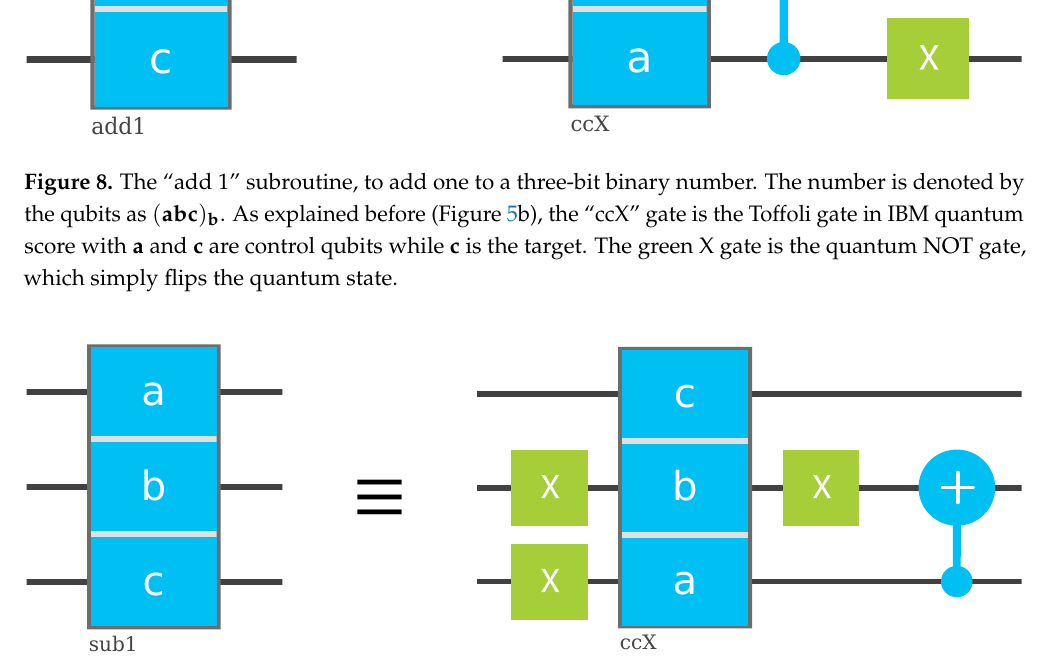
Figure 9. The “sub 1” subroutine, to subtract one from a three-bit binary number. The number is denoted by the qubits as ( abc ) b . The “”ccX” gate is the Toffoli gate (Figure 5b). Where the qubits denoted by “a” and “b” are control qubits while “c” is the